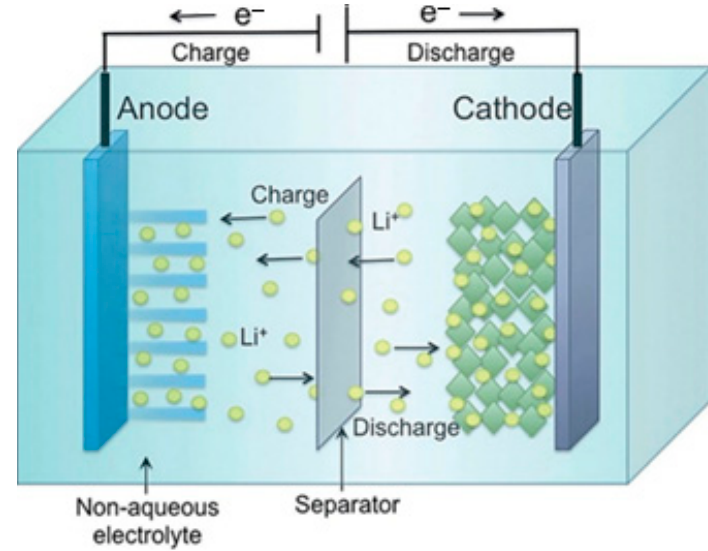
Figure 5. Lead–acid battery construction.